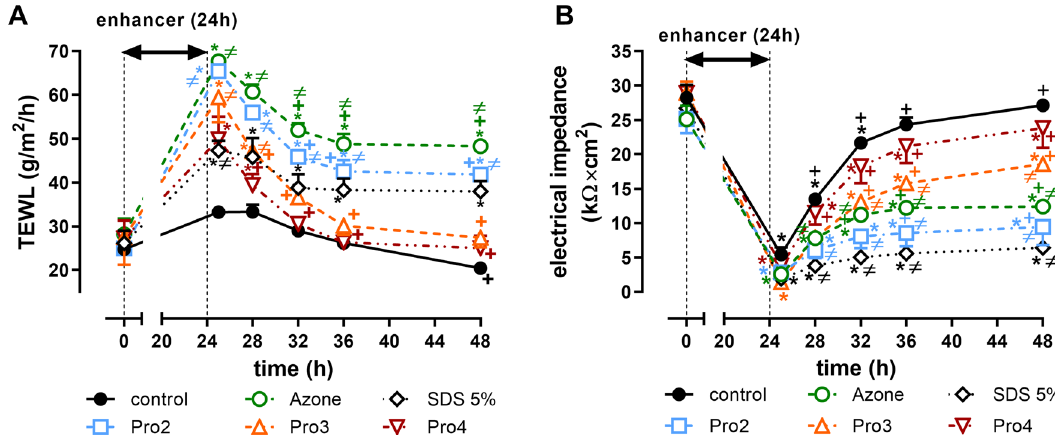
Figure 5. TEWL ( A ) and impedance ( B ) values before (0 h) and after 24-h application of 60% PG without (control) or with 1% enhancer (Pro2, Pro3, Pro4) or positive controls (1% Azone or 5% SDS); n = 4. *Statistically significant difference compared to the baseline value before the sample application at p < 0.05. + Statistically significant compared to the value after the sample removal (25 h) at p < 0.05. ≠ Statistically significant compared to the control (60% PG without enhancer) at the same time point, at p < 0.05. The values are given in Supplementary Table